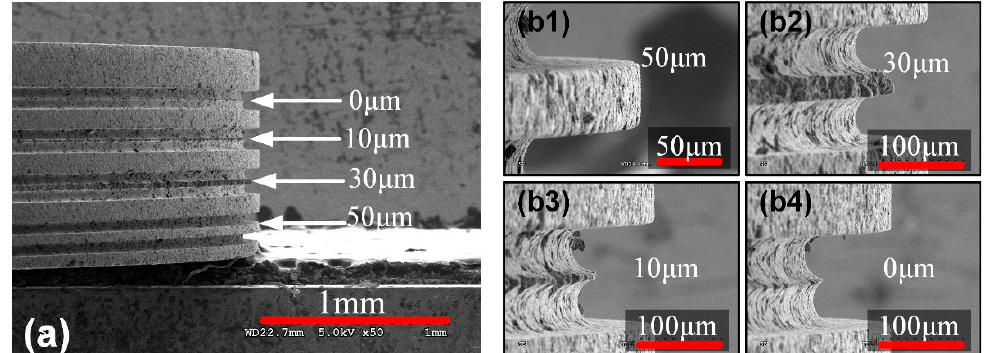
Figure 4. SEM images of the graphite disk electrode by micro-WEDM with the thickness of 10 μ m, 30 μ m, 50 μ m and no offset distance (0 μ m). ( a ) SEM image of the as-prepared graphite disk electrode. ( b1 – b4 ) The enlarged view of the thin edges with different width.